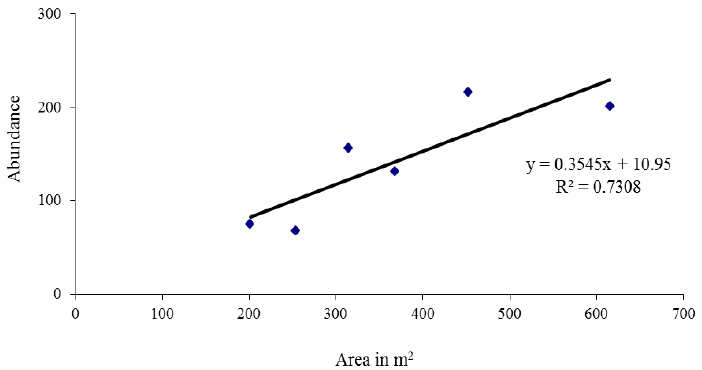
Figure 2. The relationships between the abundance of the fruit-feeding butterflies and the area of the gaps in Silent Valley National Park, Western Ghats, India. Temporal variation in abundance was modest, with a peak near the end of the wet season. This was consistent among the four habitats (Figure 3). All common species fol- lowed this pattern (all discernible peaks fell in the period October – December), hence there